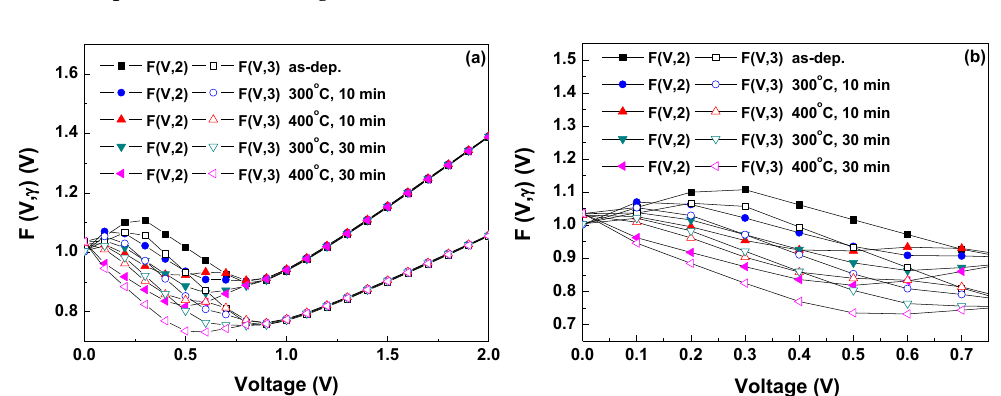
Figure 5. Norde plots of the Mo/SiC Schottky contacts with various annealing conditions: ( a ) 0 – 2.0 V; and ( b ) 0 – 0.75 V.